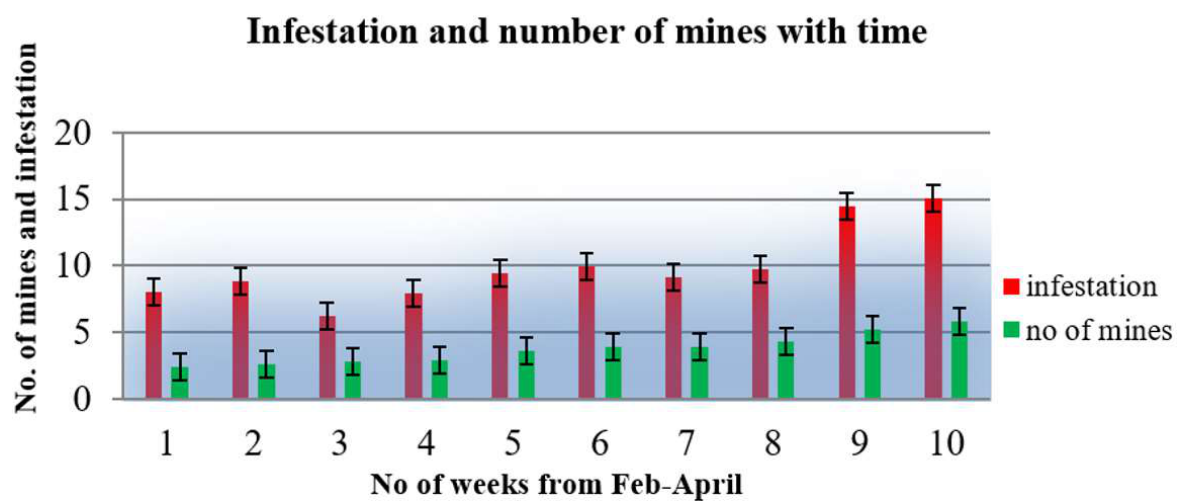
Figure 3. Infestation and No. of mines increased over time in controlled